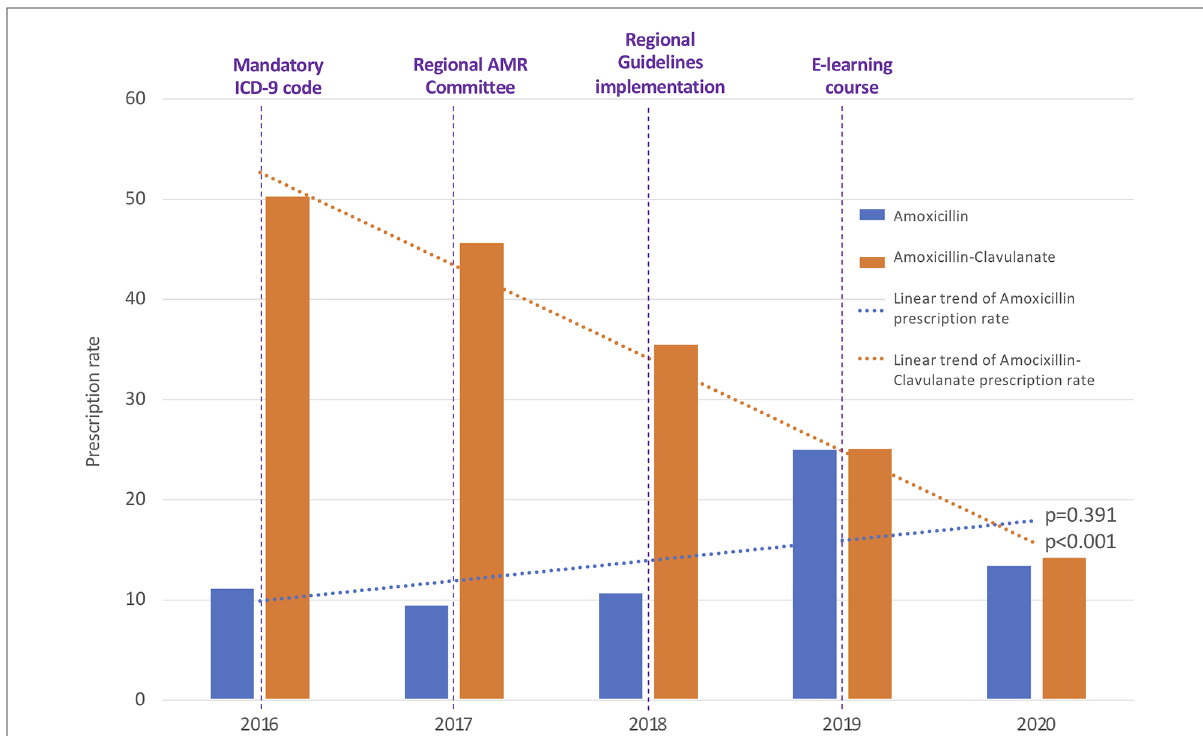
FIGURE 3 Annual antibiotic prescription rates of amoxicillin and amoxicillin-clavulanate. ICD-9, International Classi fi cation of Diseases-9; AMR, Antimicrobial